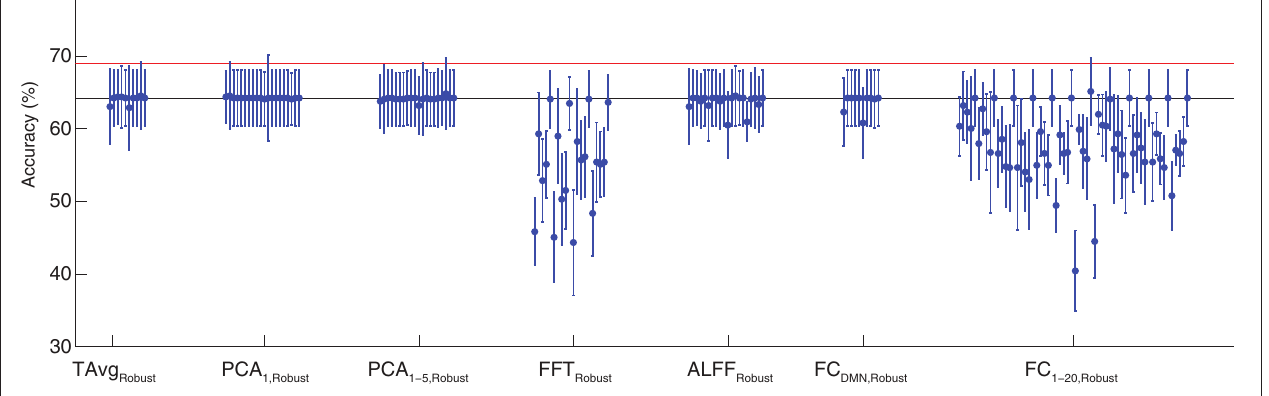
FIGURE 4 | Top: Accuracies on the binary diagnosis task (controls vs. ADHD) using features derived from the robust cluster identification procedure (section 2.6) with five different classifiers (section 2.2). Each blue dot with error bars shows the mean accuracy and standard deviation for one Diagnostic Pipeline (feature data and classifier combination) on 10-fold cross validation with the 668 participant Training Dataset. The black horizontal line at 64.2% accuracy indicates chance baseline (guessing healthy control for all participants). The red horizontal line at 75.0%